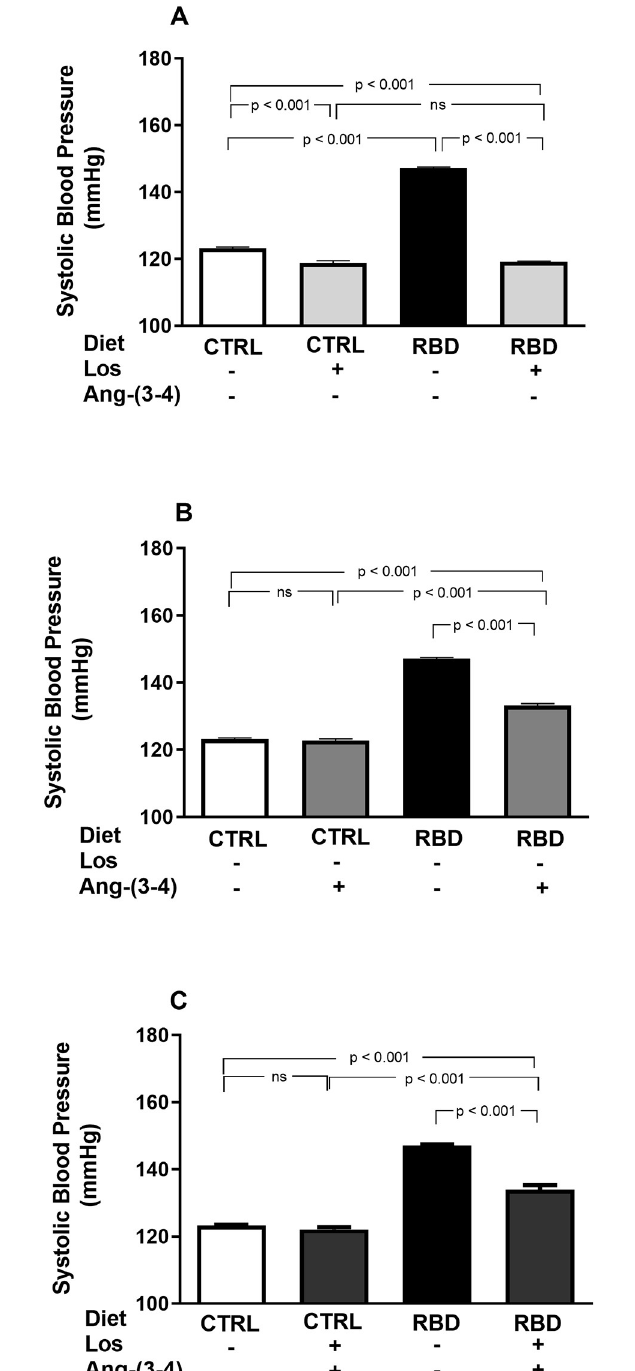
Fig 7. Systolic blood pressure. Losartan- and Ang-(3–4)-sensitive elevated systolic blood pressure (SBP) in undernourished rats. SBP was recorded in animals aged 91 or 92 days (in the case of Ang-(3–4)-treated rats) fed on CTRL or RBD diets. (A) Effects of Losartan. Comparison of SBP in CTRL and RBD rats without chronic administration of Losartan, and effects of Losartan administration (30 mg/kg body mass per day, from 28 to 92 days of life) to CTRL and RBD rats, as indicated on the abscissa . (B) Responses to Ang-(3–4). Effects of oral administration of a single dose of Ang-(3–4) (80 mg/kg body mass), at 91 st day of life, to CTRL and RBD rats, as indicated on the abscissa . (C) Responses to Losartan+Ang-(3–4). Effects of combined administration of Losartan and Ang-(3–4) to CTRL and RBD rats, as shown on the abscissa . Bars are mean ± SEM; n = 10 (CTRL), n = 24 (RBD), n = 14 (CTRL